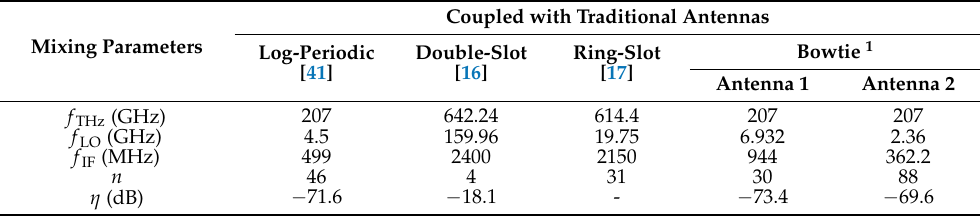
Table 1. Performance comparison of HTS JJ mixers coupled with different traditional antennas with the detected maximum harmonic